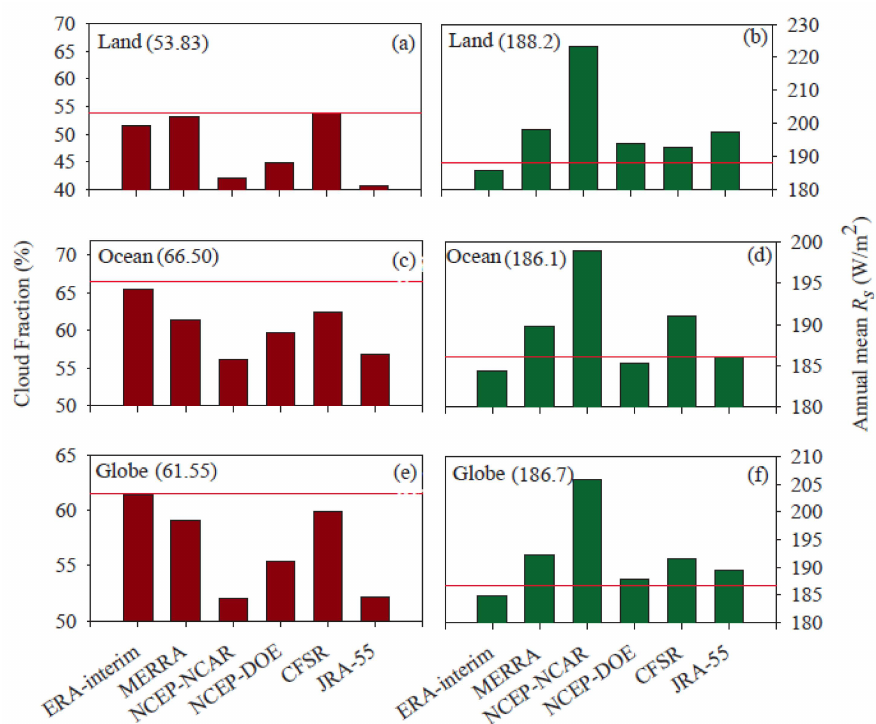
Figure 8. Multi-year annual mean cloud fraction (CF) and R s obtained from the global reanalyses and CERES data from 2001 to 2009: ( a ) CF for land; ( b ) R s for land; ( c ) CF for oceans; ( d ) R s for oceans; ( e ) CF for the global; ( f ) R s for the globe. The numbers in the brackets and the red lines indicate the multi-year annual mean CF and R s calculated from CERES data.